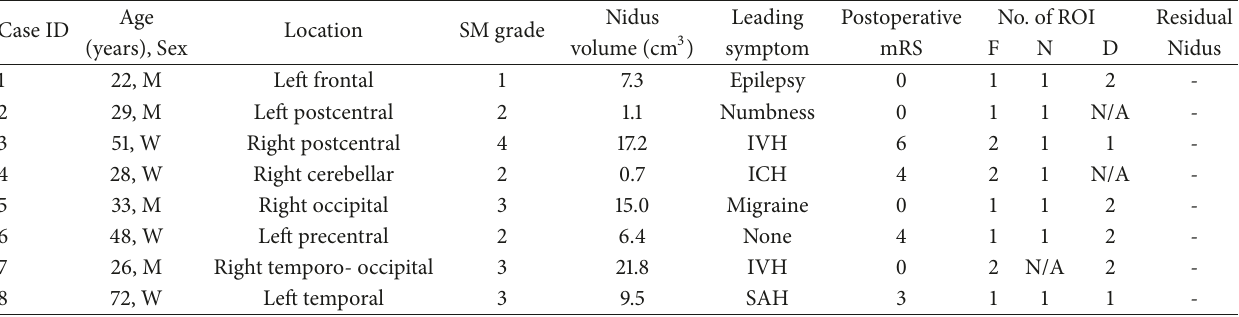
Table 1: Patients